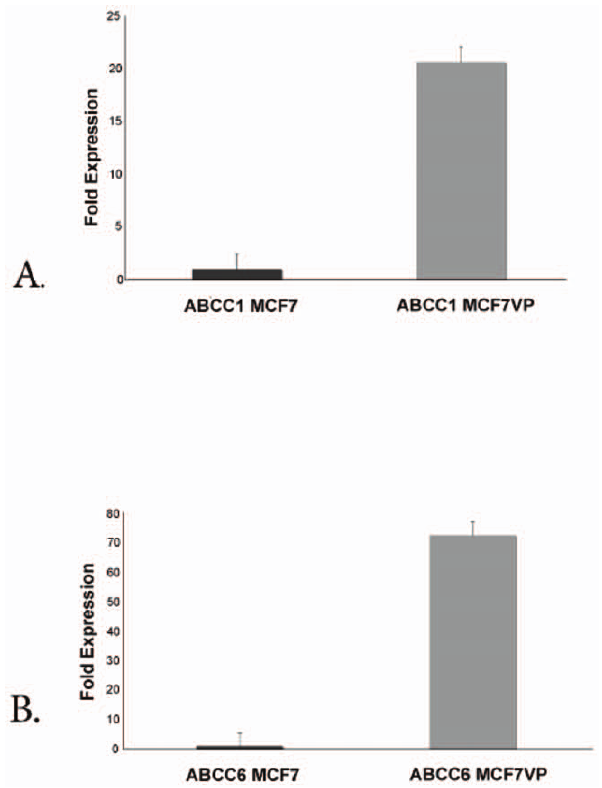
Figure 3. Expression of ABCC1 and ABCC6 in MCF7VP cells, Fig. 3A. Up-regulation of ABCC1 in MCF7VP cells validated by qRT-PCR. The gene expression level of ABCC1 was found to be up-regulated in the MCF7VP cell line using microfluidic arrays, this was validated using quantitative RT PCR with taqman probes against ABCC1. The fold change was calculated using the delta delta CT method. Fig. 3B. Up- regulation of ABCC6 in MCF7VP cells validated by qRT-PCR. ABCC6 up- regulation was validated with quantitative qRT PCR and taqman probes against ABCC6. The fold change in gene expression between the MCF7 and MCF7VP was calculated using the dd CT method.